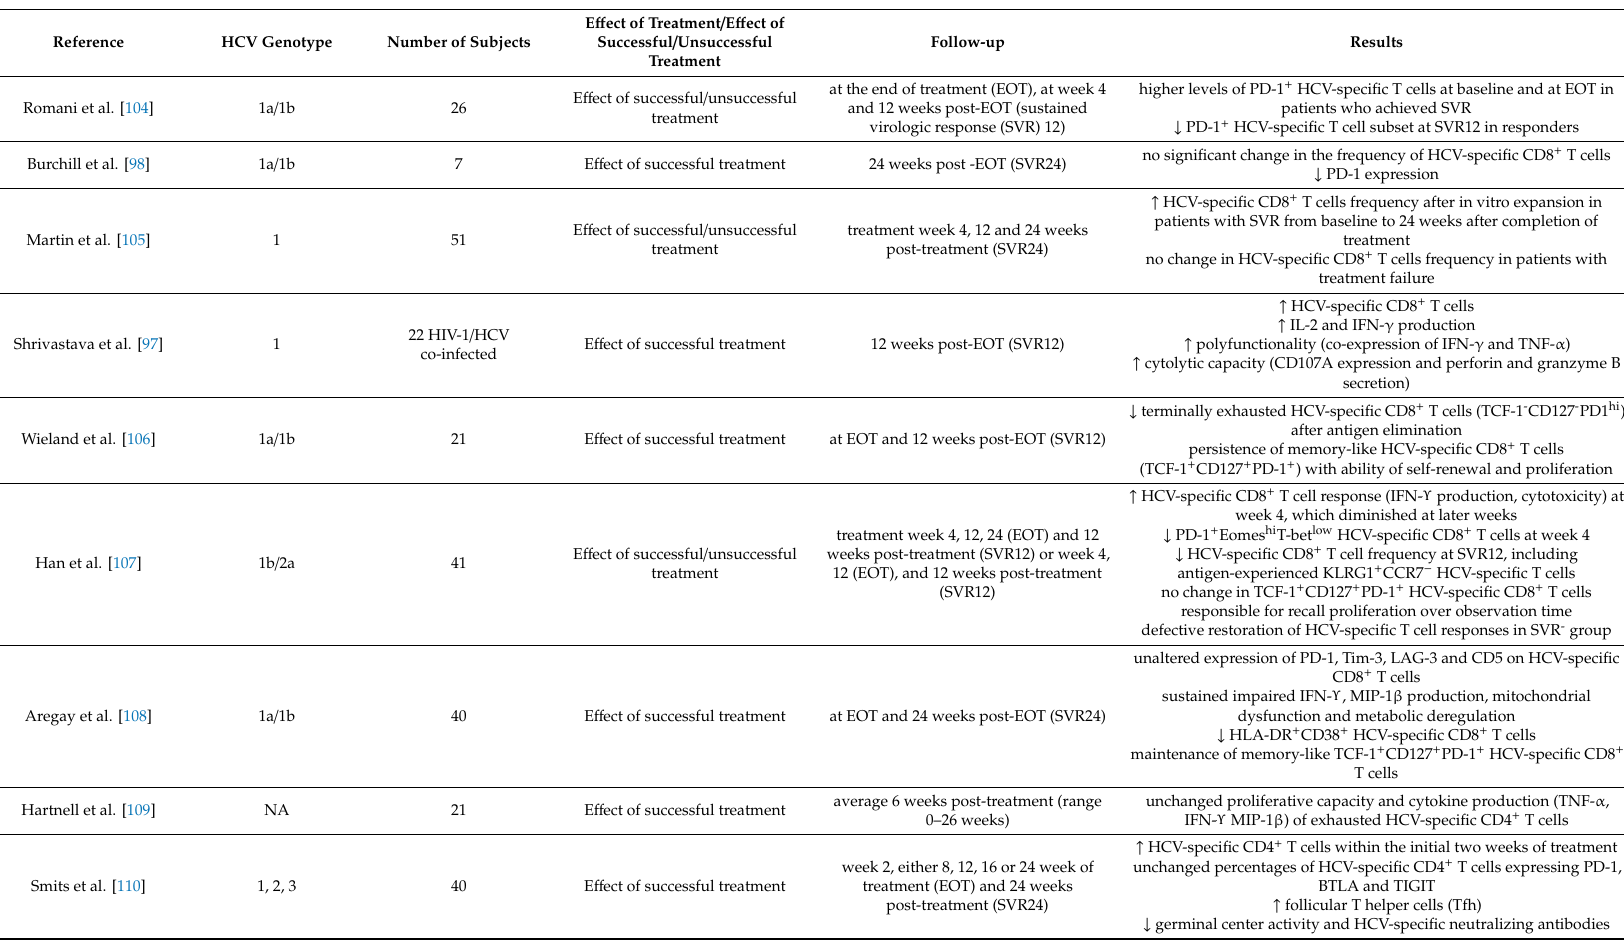
Table 3. Studies reporting the e ff ect of DAA-treatment on peripheral HCV-specific T cell phenotype or function in chronic HCV infection.